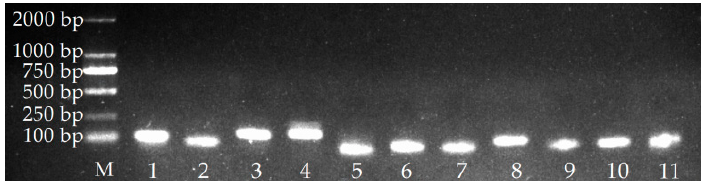
Figure 1. PCR products for 11 reference genes. M: DNA marker, 1: 18S rRNA, 2: E2, 3: eIF4A, 4: